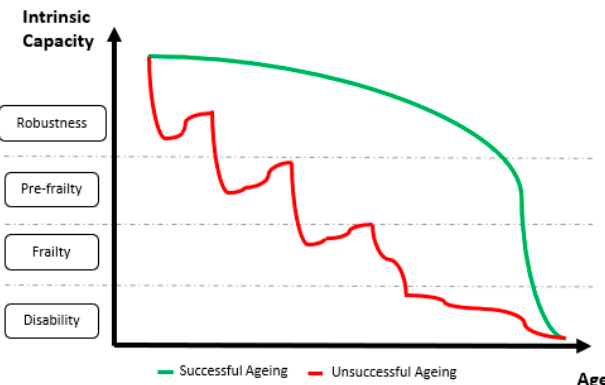
Figure 1. Graphical representation of simulated successful and unsuccessful aging trajectories. The horizontal axis represents the advance of time from the beginning of the old age to the end of life. The vertical axis represents the categories in which patients fall along the progress of functional decline (from robustness to disability). The green line represents a successful aging trajectory: good functional status is enjoyed for most of the old age and functional decline only happens rapidly and close to the end of life. The red line represents an unsuccessful aging trajectory: a clear trend of fast functional decline is observed throughout old age together with a long period of disability, several years long, before the end of life.